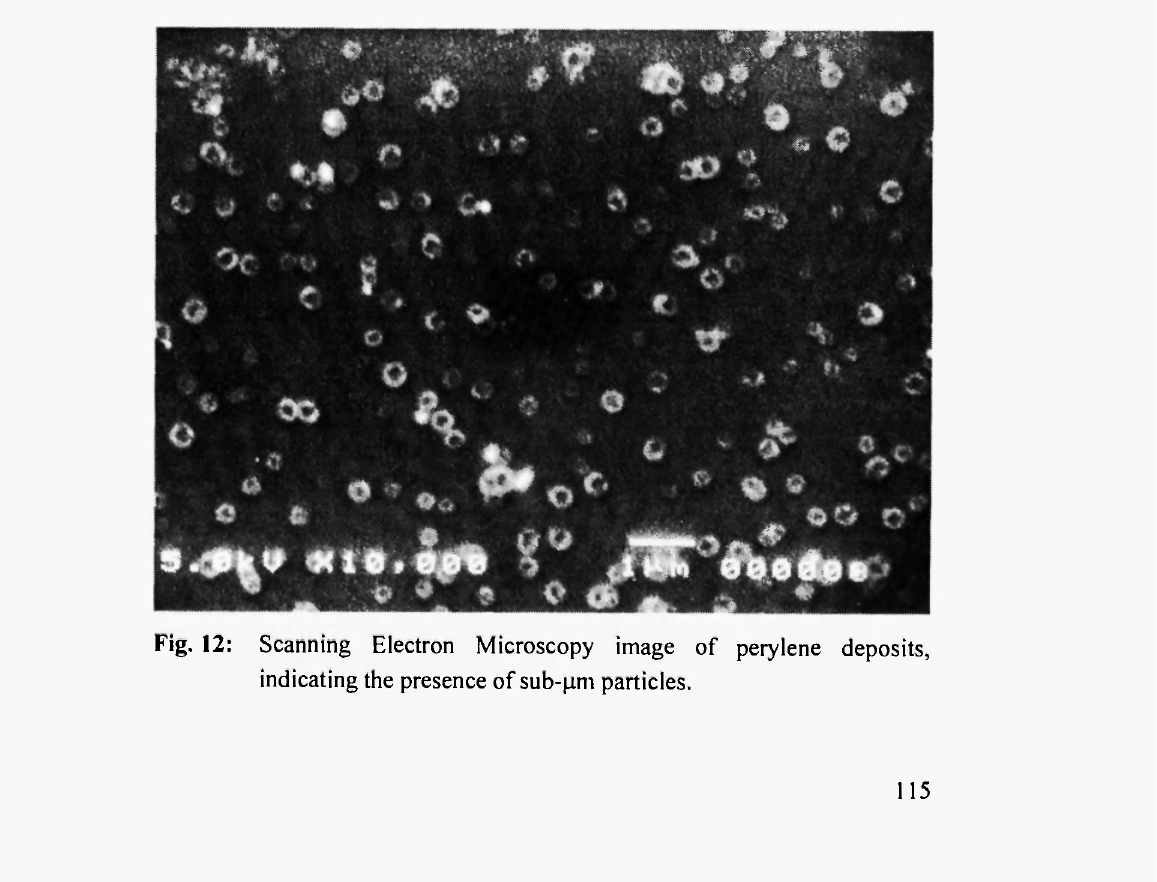
Fig. 12: Scanning Electron Microscopy image of perylene deposits, indicating the presence of sub-μηι particles.